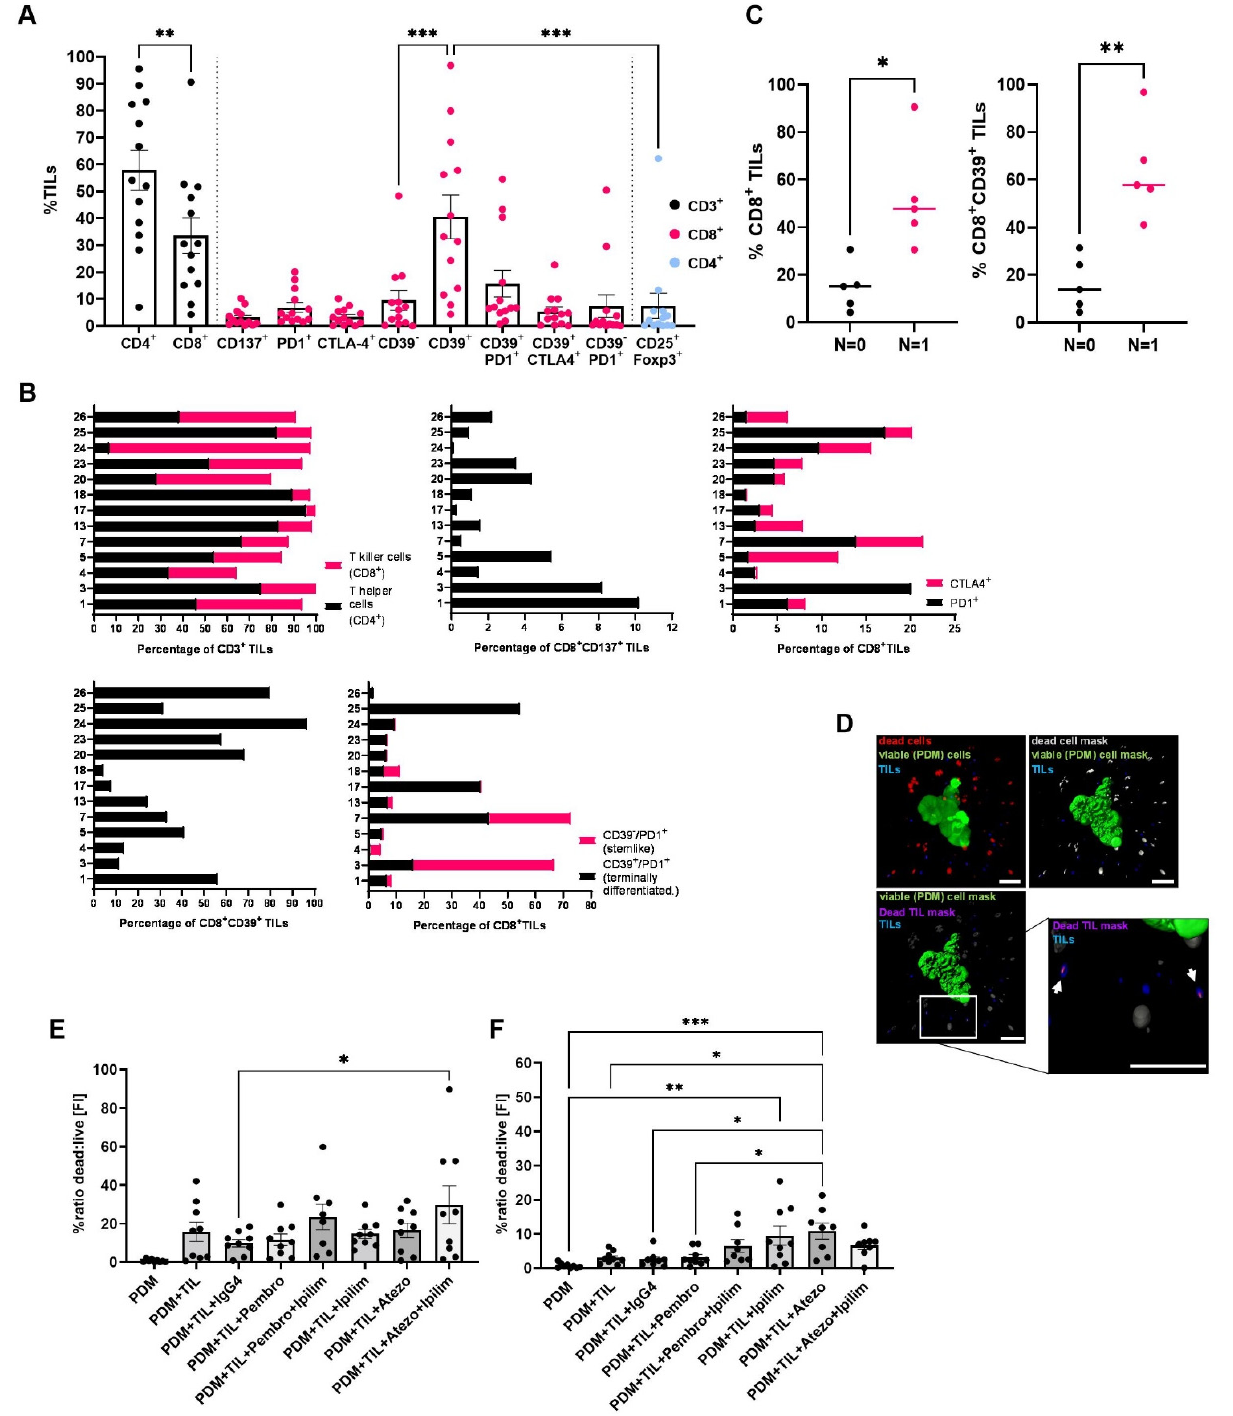
Figure 5. CPI treatment in OvCa PDM-TIL co-cultures increased functional TIL killing capacity. Autologous TIL populations were isolated and expanded from OvCa tissue specimen. ( A ) Percentages of different TIL populations within CD3-, CD8- and CD4-positive T cells of different models were quantified by multicolor flow cytometry. Data are shown as means ± SEM of at least n = 10 OvCa samples. * p < 0.05, ** p < 0.01, *** p < 0.001, ANOVA with Holm-Šídák’s post hoc test. ( B ) Phenotypes of extracted TIL populations shown separately for each OvCa model. ( C ) Percentages of CD8 + and CD8 + CD39 + TILs in OvCa patients with lymph node spread ( n = 1) and without lymph node spread ( n = 0). All points with median are shown. * p < 0.05, ** p < 0.01, Mann–Whitney- U -test. ( D ) PDM killing effects were measured in an image-based assay format as ratio of fluorescent